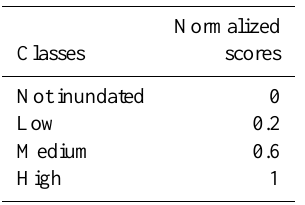
Table 5. Qualitative evaluations supporting the expert in the assign- ing of relative scores to susceptibility and risk classes.